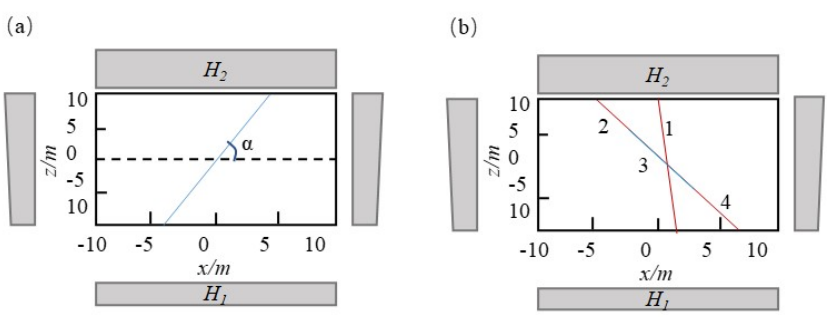
Figure 6. Sketch of the simple fracture networks and hydraulic boundary conditions [63]: ( a ) single fracture network: nine sets of single fractures with different slopes ranging from 50° to 90°, with an interval of 5°; ( b ) intersecting fracture network: four cracks with through fracture 1 and non-through fractures 2, 3, and 4, with fractures 2, 3, and 4 being connected to form a hydraulic conduit. A hydraulic head ( H 1 = 30 m at the top and H 2 = 10 m at the bottom) drives the flow, with vertical hydraulic gradients of 1 m/m at the left and right boundaries of the fracture system.